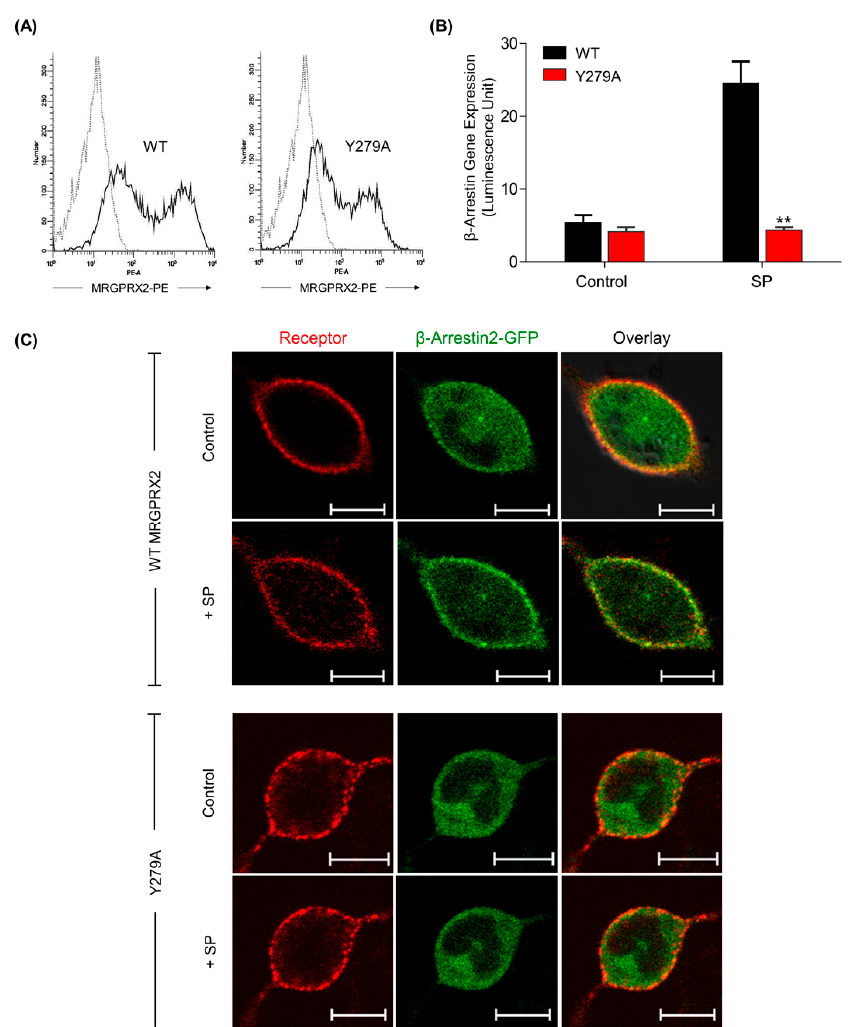
Figure 4. Y279A mutation of MRGPRX2 abolishes β -arrestin recruitment in response to SP. ( A ) HTLA cells were transiently transfected with cDNA encoding either WT-MRGPRX2 or its Y279A mutant, and cell surface receptor expression was determined by flow cytometry using PE-anti-MRGPRX2 antibody. ( B ) Cells were stimulated with SP (30 µ M) for 16 h, and β -arrestin–mediated gene expression was measured. All data points are the mean ± SEM of at least three experiments. Two-tailed unpaired t-test was used. ** p < 0.01. ( C ) RBL cells co-expressing WT MRGPRX2 or Y279A and β Arr2- GFP were stimulated with SP (30 µ M) for 1 min and β -arrestin translocation was investigated by confocal microscopy. Scale bar = 10 µ